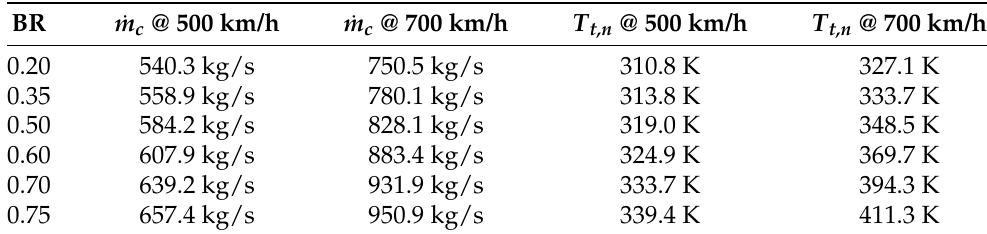
Table 2. Internal mass flow and nozzle total temperature for the different cases